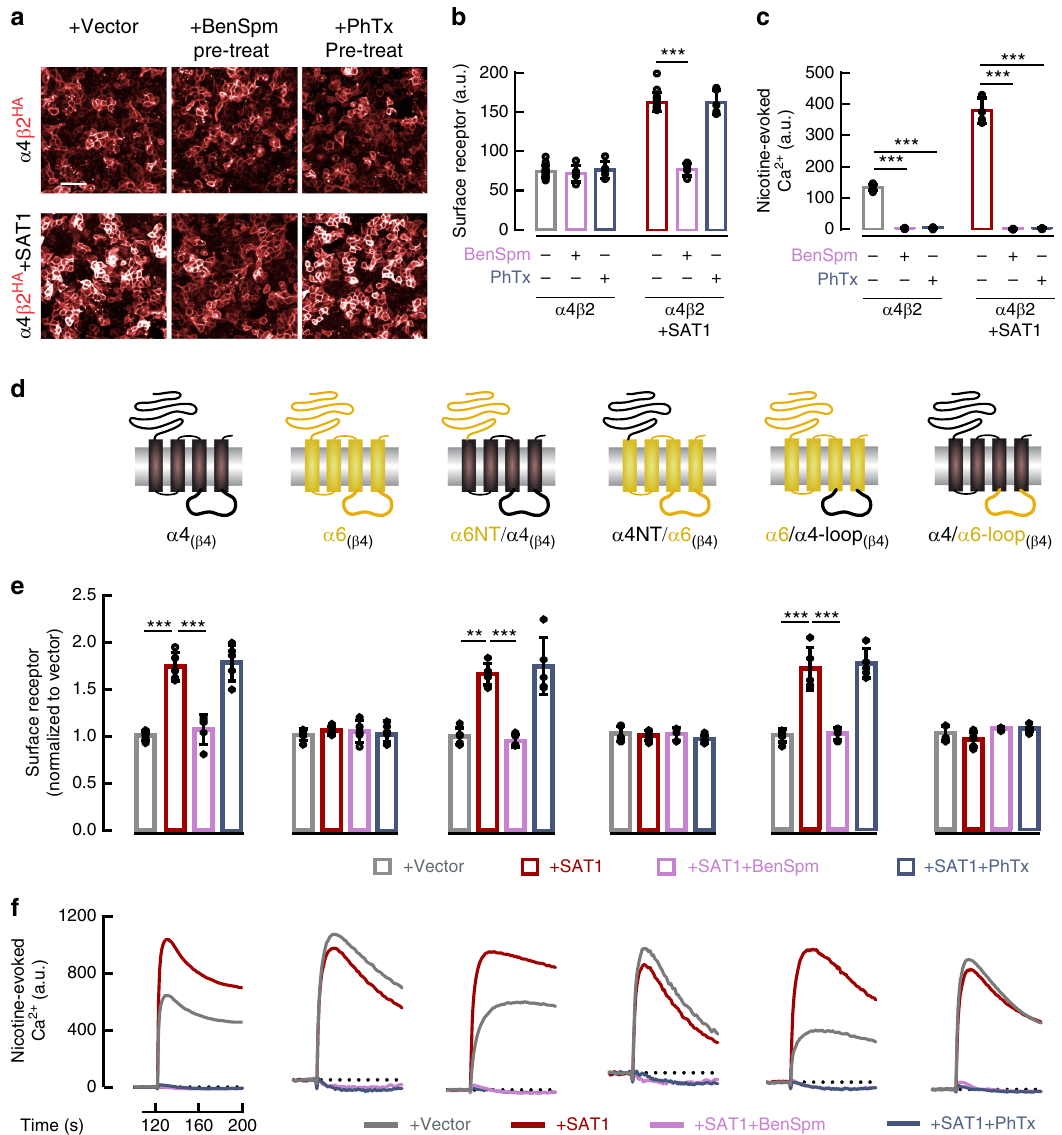
Fig. 5 Polyamine analogs regulate nAChR gating and assembly by distinct mechanisms. a Fluorescent anti-HA labeling of non-permeabilized HEK293T cells transfected with cDNAs encoding extracellular HA-tagged β 2 and α 4 with or without SAT1. Scale bar = 50 μ m . b Quanti fi cation of surface staining for α 4 β 2 receptors with or without SAT1 and BenSpm or PhTx343 pre-treatment ( n = 6). BenSpm occluded the SAT1-enhanced receptor surface expression ( p < 1e − 4 ) but PhTx343 had no effect ( p = 0.86). c Nicotine-evoked Ca 2 + signal was fully blocked by both BenSpm or PhTx343 ( p < 1e − 4 ) ( n = 6). d Schematics of chimeric constructs of α 4- α 6. e Normalized anti-HA surface expression from cells transfected and treated with BenSpm or PhTx343 as indicated ( n = 5). Only BenSpm occluded SAT1-mediated enhancement of surface receptor expression of α 4 β 4 ( p < 1e − 4 ), α 6NT/ α 4 β 4 ( p < 1e − 4 ) and α 6/ α 4-loop β 4 ( p < 1e − 4 ). Both SAT1 and BenSpm effects on receptor surface expression required the α 4 cytosolic loop. f Both BenSpm and PhTx343 fully inhibited nicotine-evoked Ca 2 + in all receptor combinations. All cDNA combinations included BARP and SULT2B1. Quanti fi cations are displayed as mean ± SD. *** p < 0.001, One-way ANOVA between the groups was used for panels b , c and e . Comprehensive dose-response studies are in Supplementary Fig. 5. Source data for panel b , c and e are provided as a Source Data fi